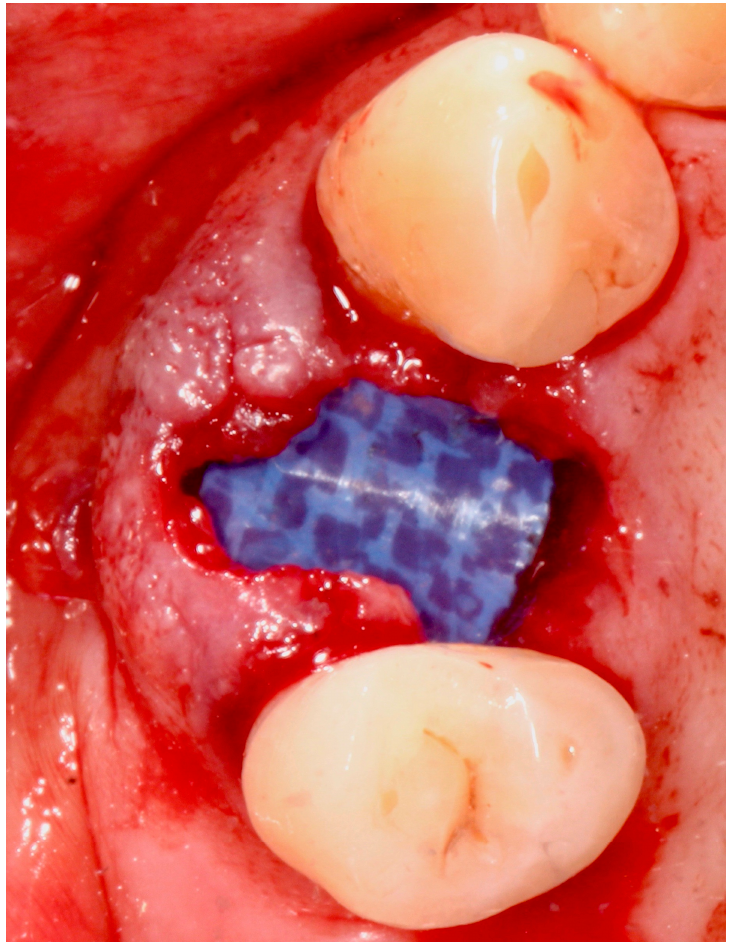
Figure 3. dense-polytetrafluoroethylene (d-PTFE) membrane placement.